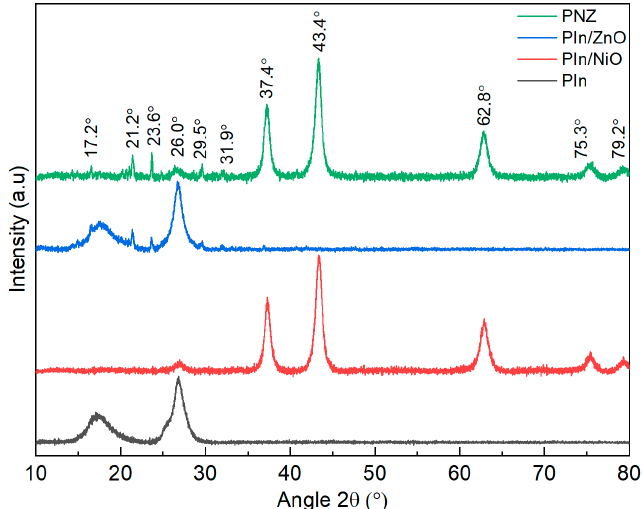
Figure 3. XRD spectra of the synthesized PIn and its metal oxide